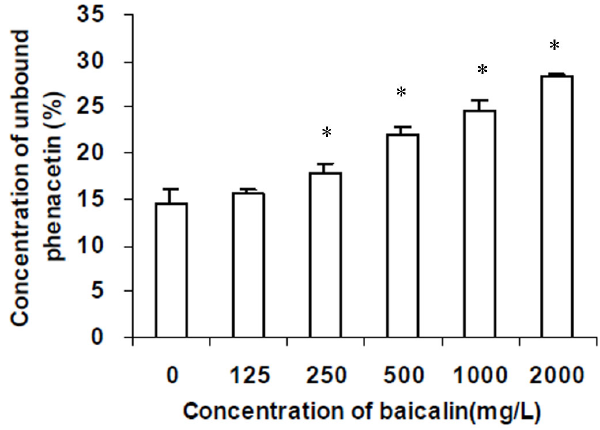
Figure 5. Plots of percentage of control in pharmacokinetic parameters of phenacetin versus AUC of baicalin. Figure 6. Effect of baicalin at concentration ranged 0 from to doi:10.1371/journal.pone.0089752.g005 2000 mg ? L 2 1 on concentration of unbound phenacetin(%) in pooled rat plasma (n=3). Total phenacetin concentration was 7 mg ? L 2 1 . *indicates a significant ( P , 0.05) increase in concentration of unbound phenacetin (%) from blank value. Table 4, baicalin (450 mg/kg, i.v.) was found to significantly decrease the C max and CL of phenacetin, and increase C 60 min , t 1/ , 0.05). The AUC and C 60 min of phenacetin in 2 , V d and AUC ( P control were (140.2 6 14.7) mg/L ? min and (0.27 6 0.14) mg/L compared with (162.8 6 21.1) mg/L ? min and (0.55 6 0.17) mg/L in